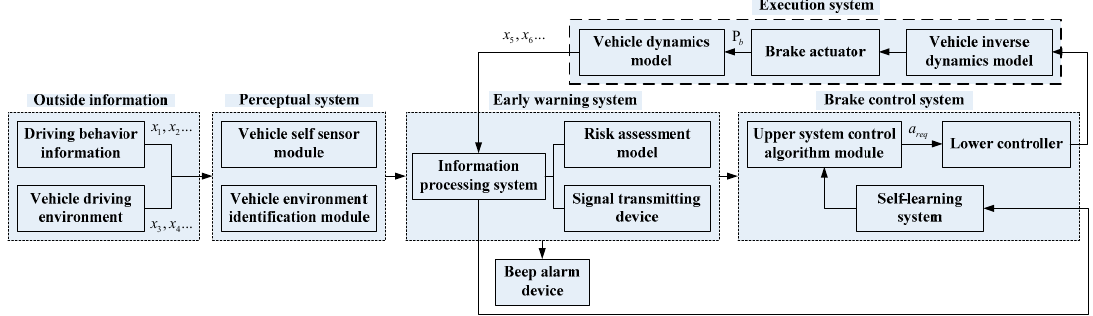
Figure 1. The proposed autonomous emergency braking pedestrian (AEB-P) system architecture.